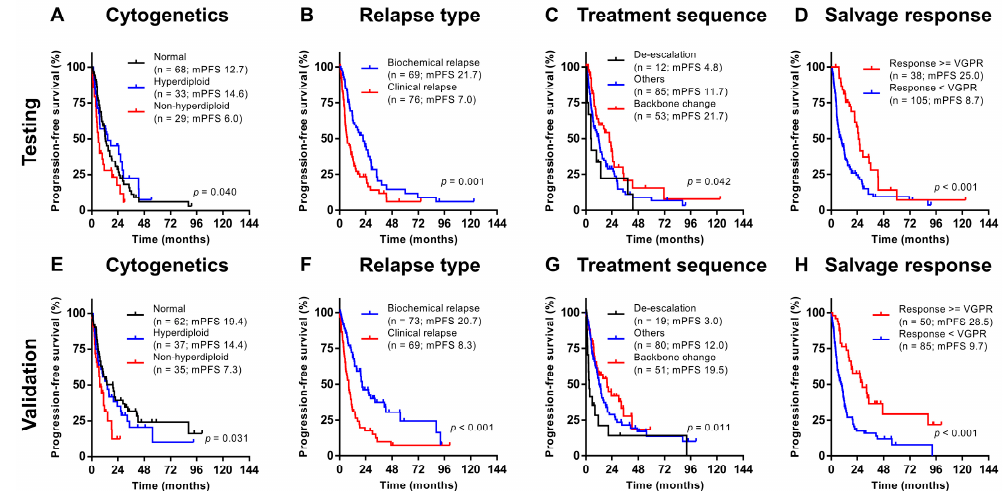
Figure 2. Progression free survival categorized according to di ff erent prognostic factors in the testing (( A ) cytogenetics; ( B ) relapse type; ( C ) treatment sequence; ( D ) salvage response) and validation (( E ) cytogenetics; ( F ) relapse type; ( G ) treatment sequence; ( H ) salvage response) cohorts.